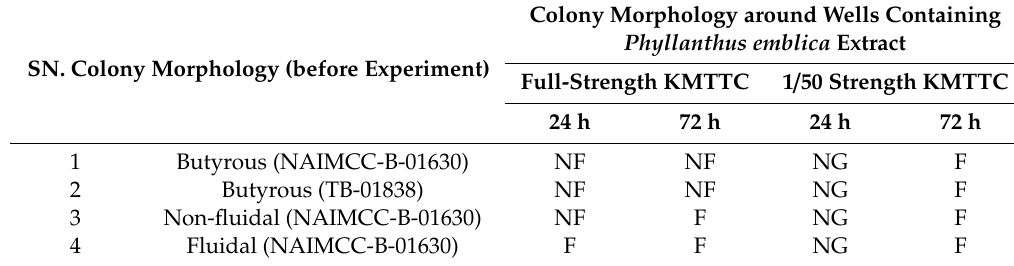
Table 1. E ff ect of the given protocol on the conversion of colony morphotypes. Table 1. Effect of the given protocol on the conversion of colony morphotypes.